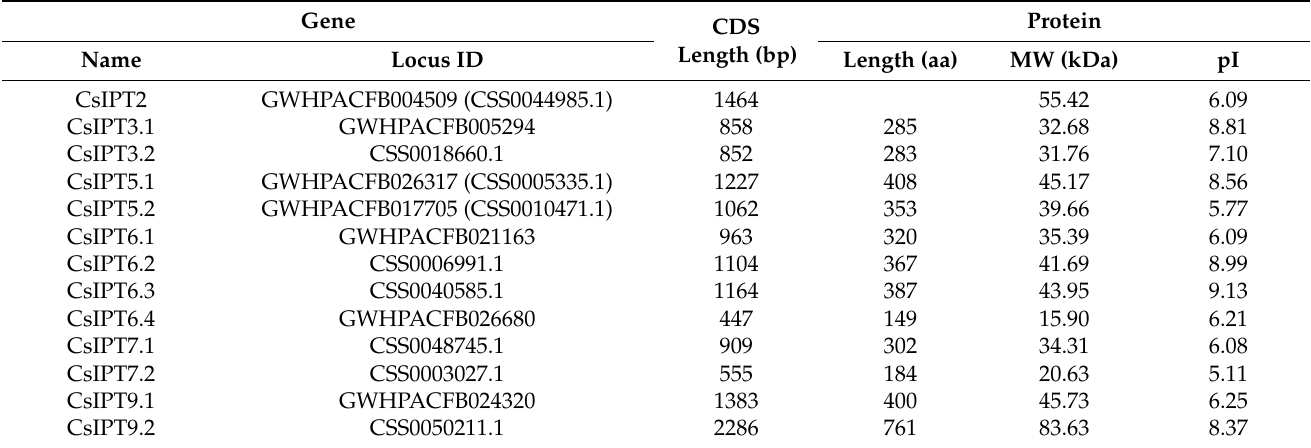
Table 1. IPT gene family in Camellia sinensis L. LJ43 and SCZ, along with their molecular details